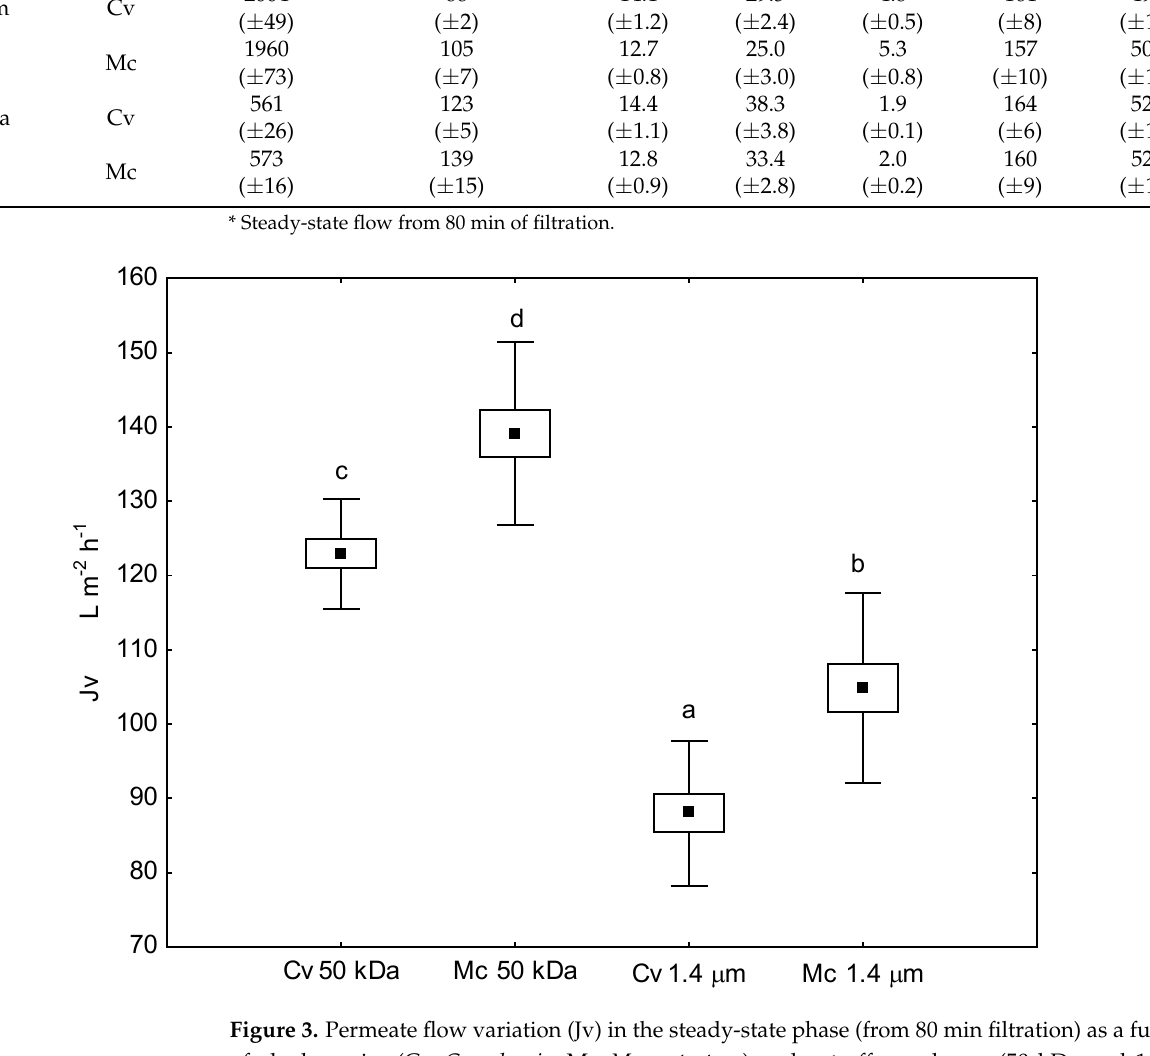
Figure 3. Permeate flow variation (Jv) in the steady-state phase (from 80 min filtration) as a function of algal species (Cv − C. vulgaris ; Mc − M. contortum ) and cut-off membrane (50 kDa and 1.4 µm) (black point-mean; rectangle-mean ± standard error; whiskers-mean ± standard deviation; a, b, c, d—different symbols indicate significant differences; ANOVA Tukey HSD test, p < 0.05).